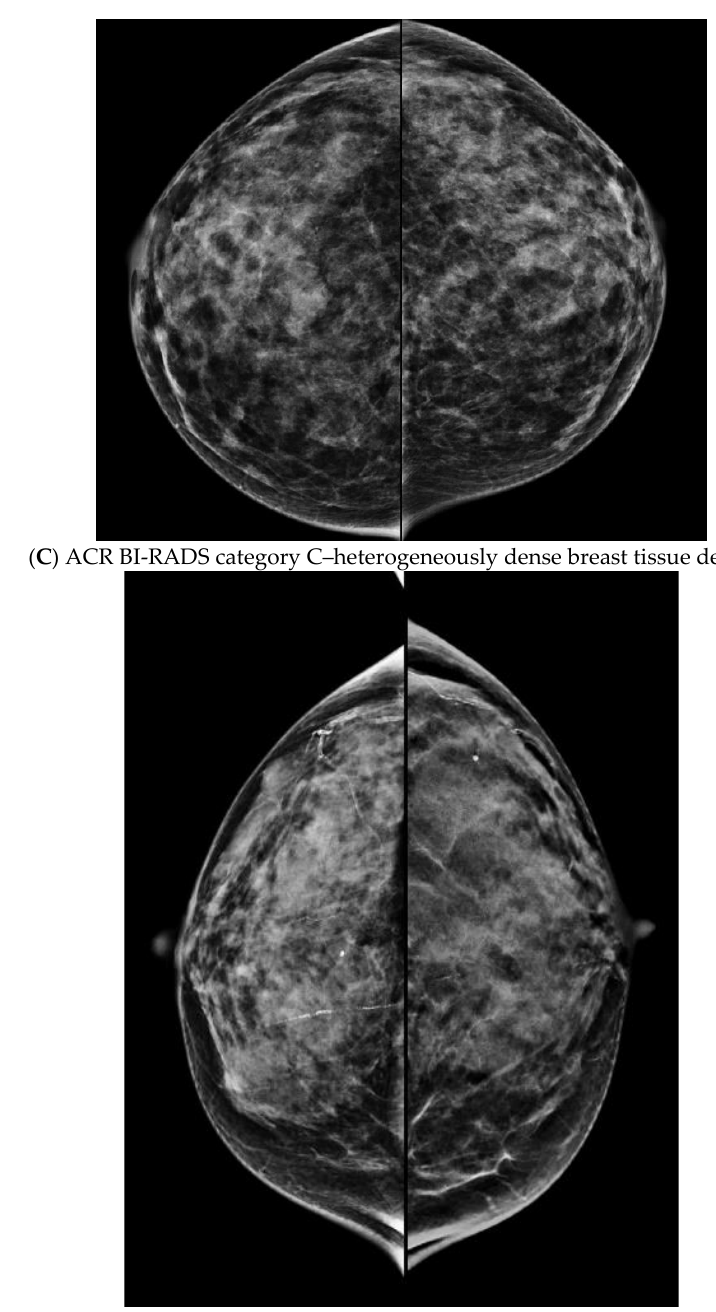
Figure 1. ACR BI-RADS categories ( A – D ) for craniocaudal mammogram views in 4 different women. As density increases from Categories ( A ) to ( D ), the masking effect increases, and the sen- sitivity of the mammograms decreases